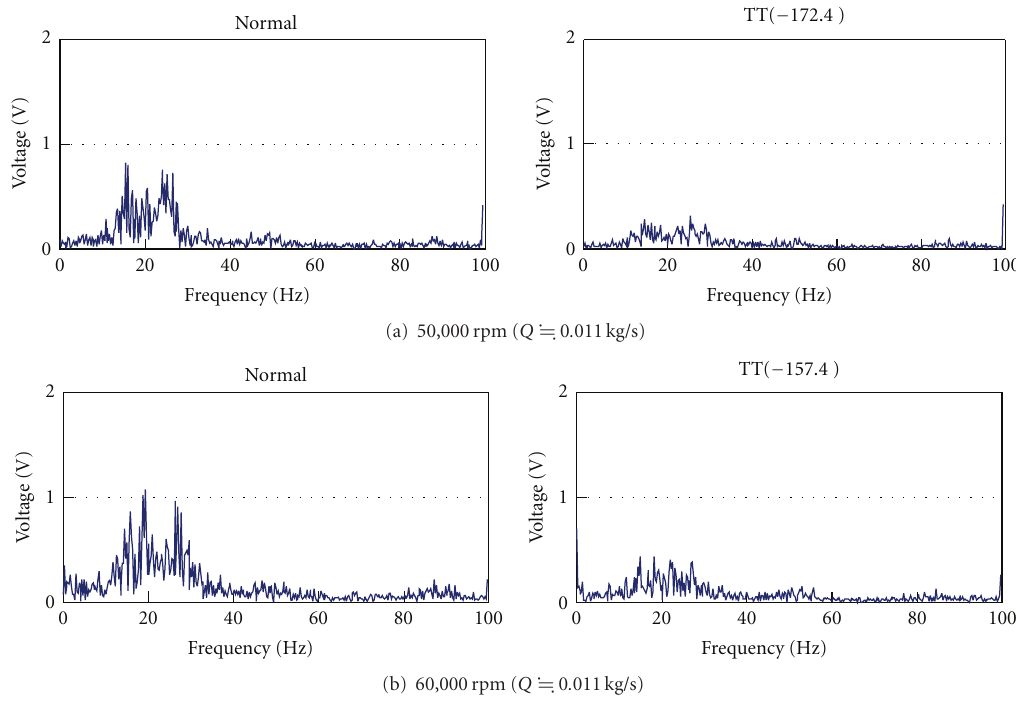
Figure 9: Spectrum of pressure fluctuation at delivery duct for Type B.